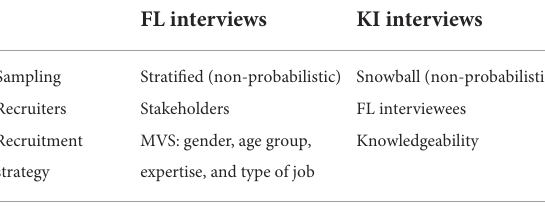
TABLE 1 Recruitment strategies for FL and KI